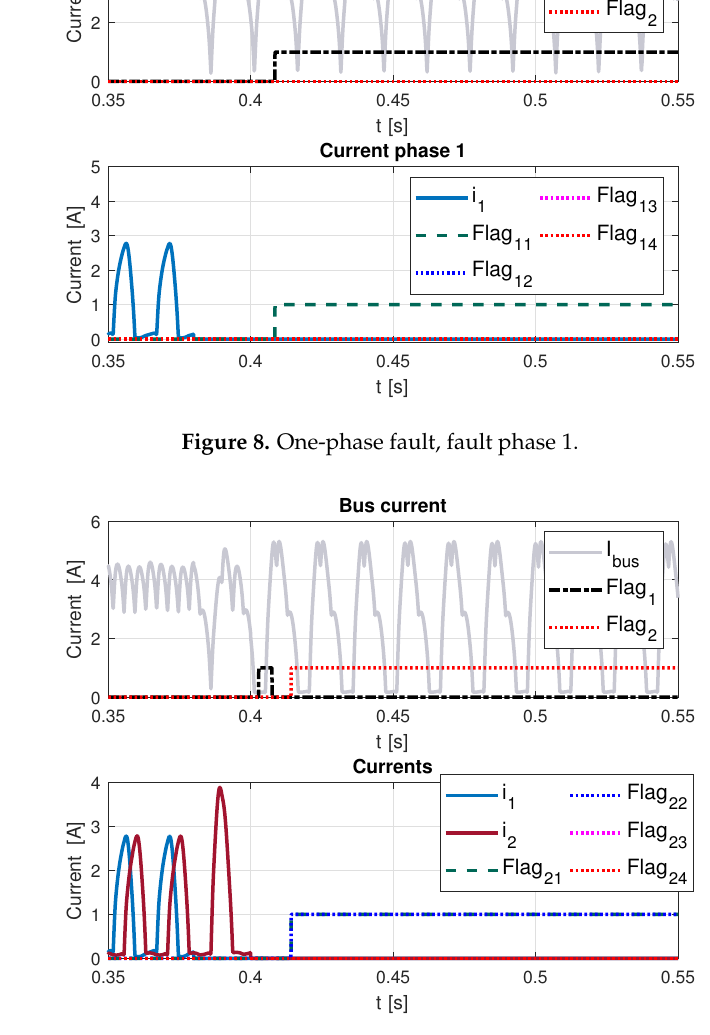
Figure 9. Two phases in fault, fault in phase 1 and